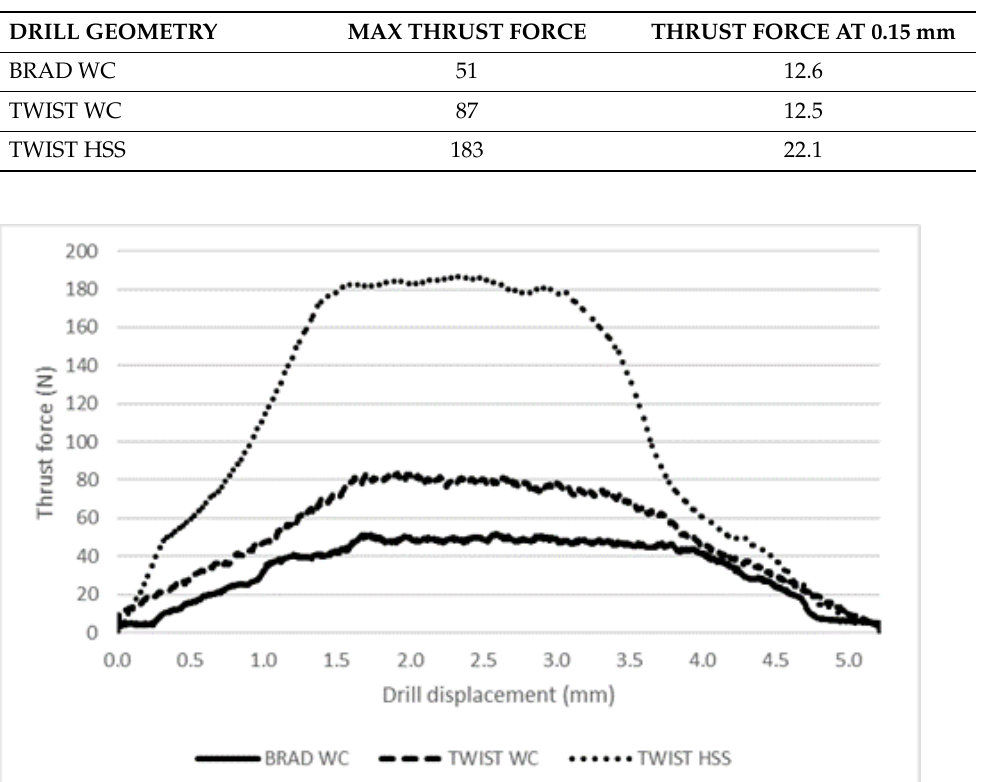
Table 4. Delamination factor (Equation (2)) and bearing strength of drilled plates.